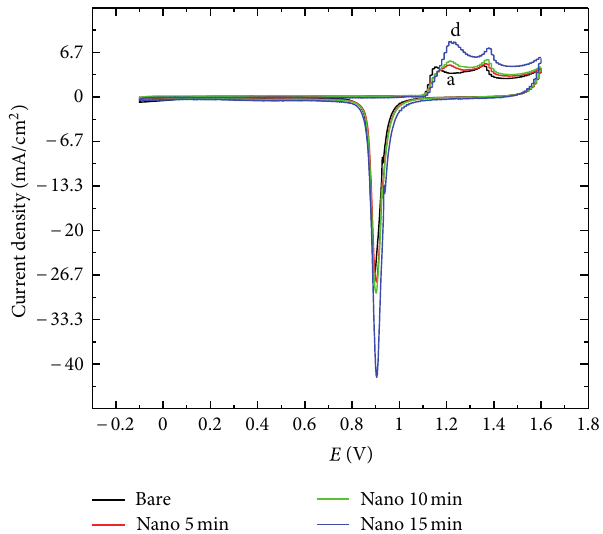
F 2: Cyclic voltammograms of (a) bare gold electrode, (b) nanogoldelectrodewithdepositiontimeof5min,(c)nanogoldelec- trode with deposition time of 10min, and (d) nanogold electrode with deposition time of 15min. Electrolyte: aqueous 1.0 M H solution. Scan rate = 50